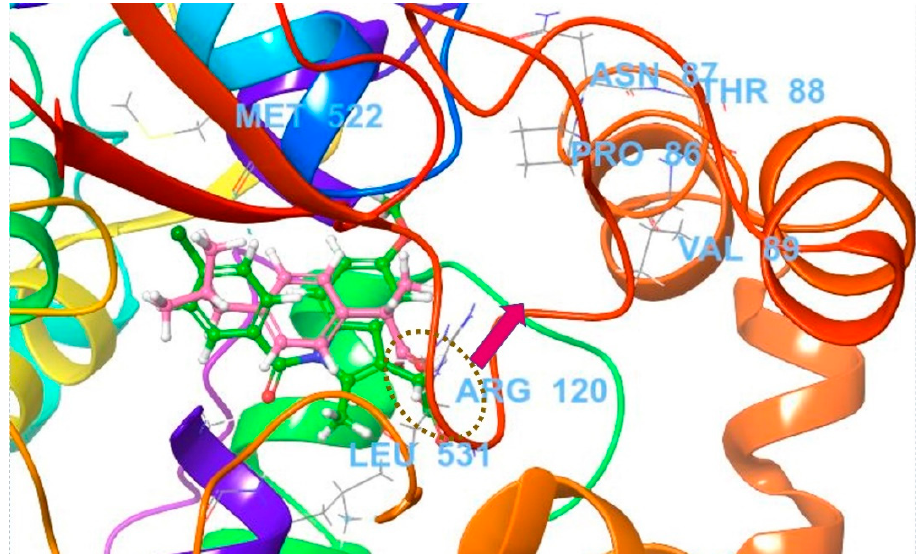
Figure 9. Overlay of docked (XP) poses of indomethacin (colored green) and ibuprofen (colored pink) in the COX-2 crystal structure, PDB: 6COX. The carboxylic acid moiety of indomethacin was used as a seed group for conjugation. Enhanced COX-2 potency was achieved by targeting Pro86 and Val89.